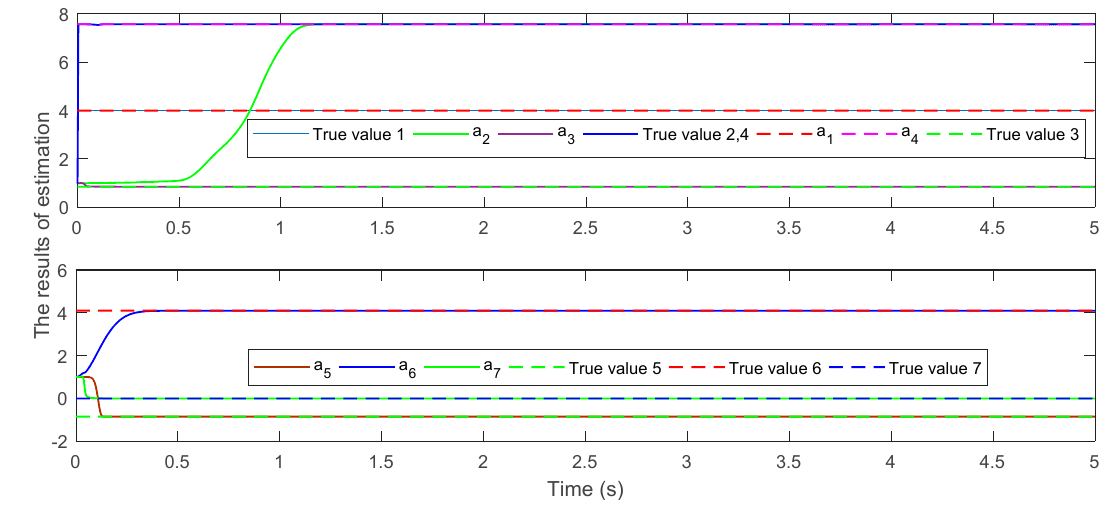
Figure 7. The estimation result of the quadrotor.